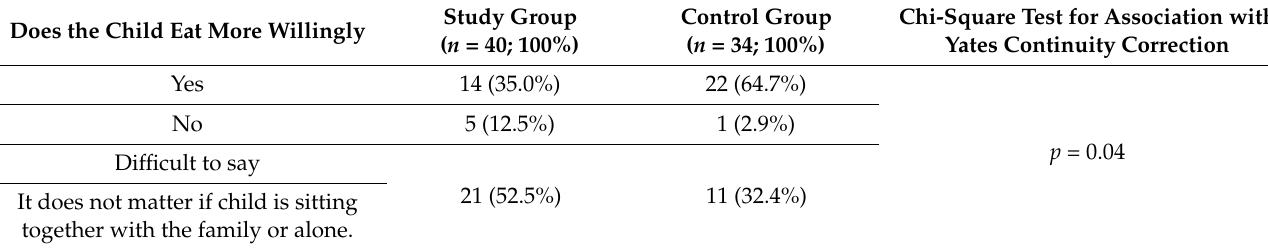
Table 15. Does the child eat food when the family eats at the table? (Question